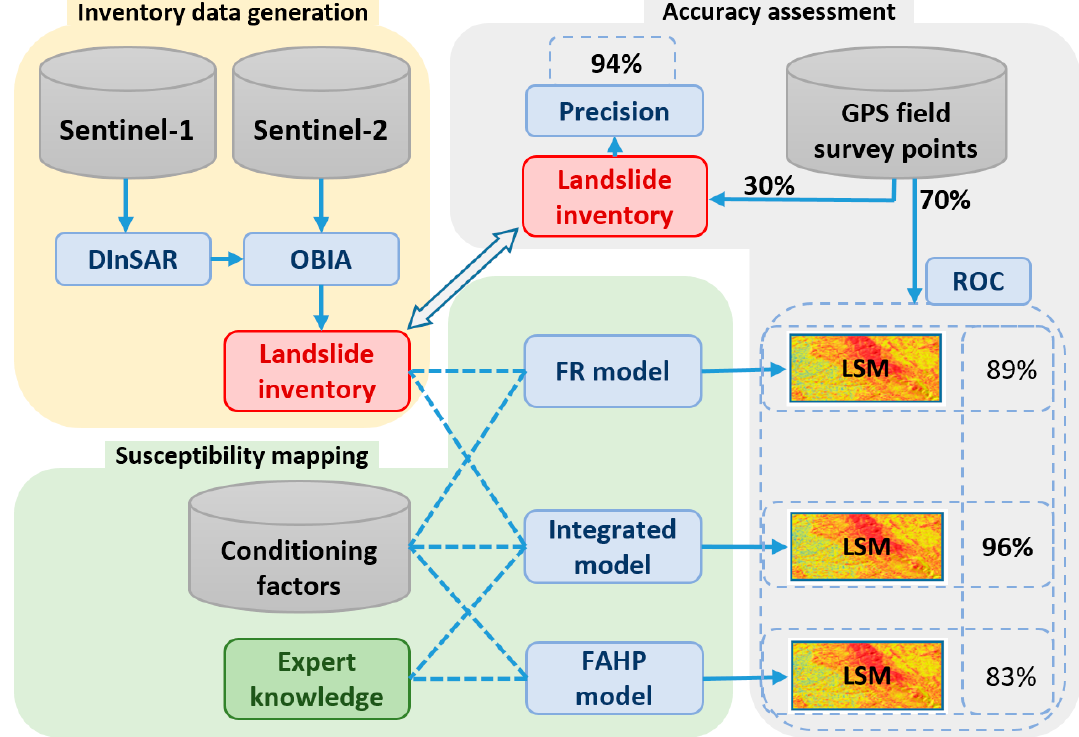
Figure 2. The schematic flowchart of the workflow of this study.